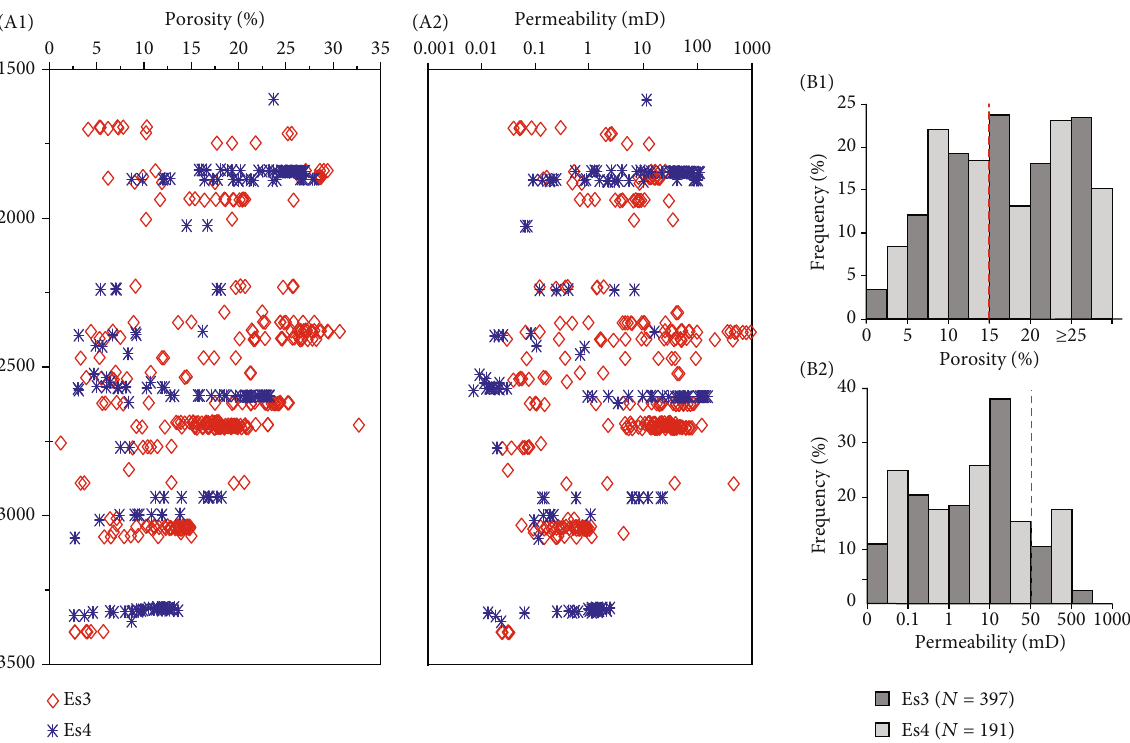
Figure 8: Petrophysical properties of sandstones in the Es3 and Es4 Formation in the Boxing Sag. (a, b) Vertical distribution of porosity and permeability. (c, d) Histogram distribution of porosity and permeability; the red dash lines distinguish low-porosity and low-permeability reservoirs.